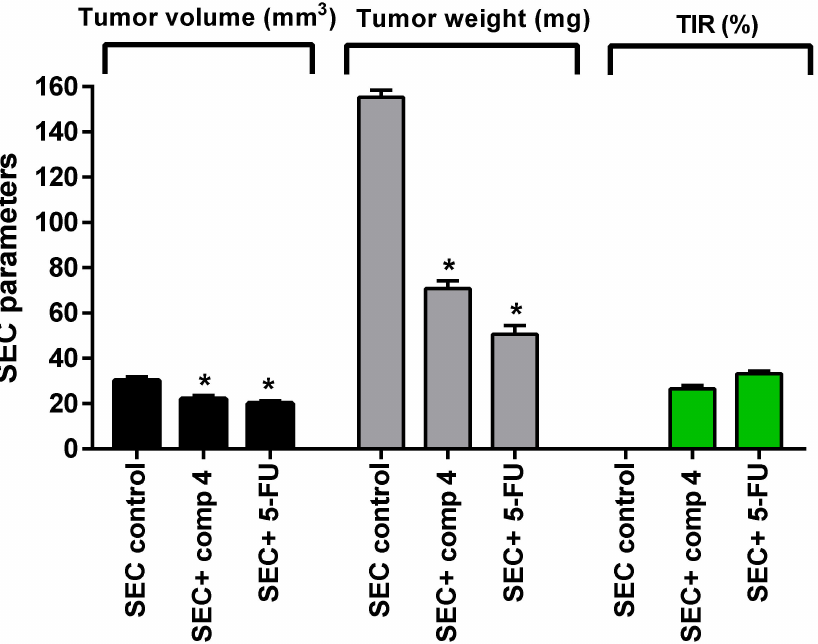
Figure 6. Solid Ehrlich Carcinoma (SEC)-bearing mice model. Di ff erent solid tumor mass, volume, tumor inhibition ratio (TIR %) values are attributed to the antitumor activity. Mean ± SEM values of mice in each group (n = 8). * Mean ± SEM values with a significant di ff erence in tumor volume and tumor weight values compared to the SEC control using an unpaired t -test ( p ≤ 0.05) using GraphPad prism. Table 4. Evaluation of liver enzymes and hematological parameters in the studied groups. Treatments Positive Control SEC Control SEC + Comp 4 SEC + 5-FU ALT * # (I / U) 43.53 ± 1.06 84.65 ± 2.1 45.75 ±